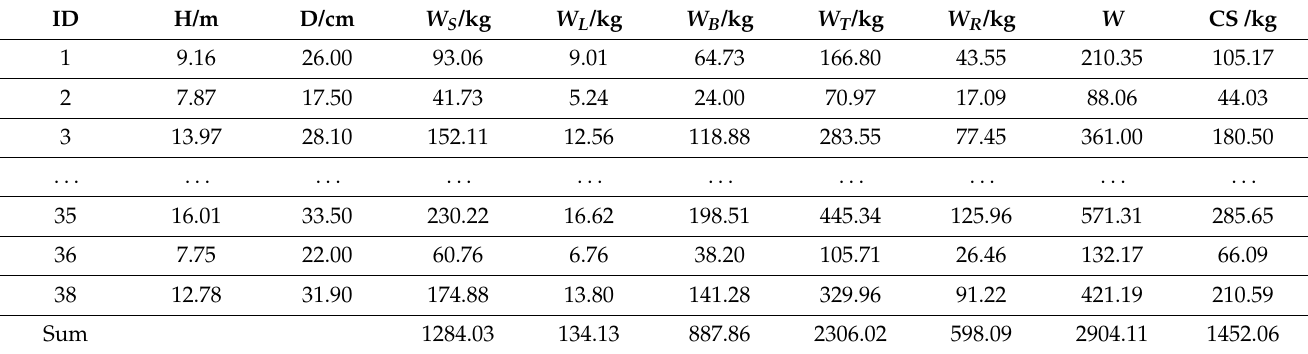
Table 5. Calculation of camphor tree carbon